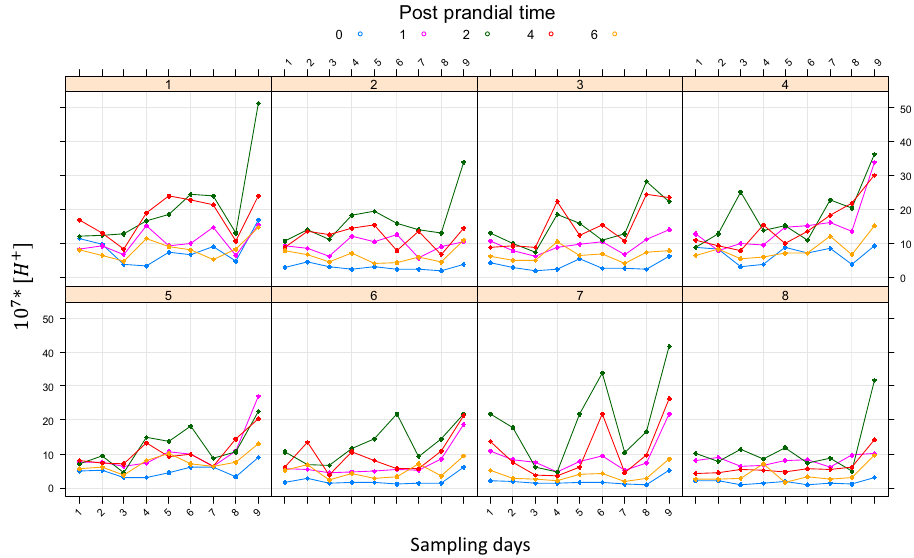
Figure 5. Individuals’ daily variations of [ H + ] . Each panel represents the post-prandial kinetics of individual goats along the 9 days of sampling. Different colours are associated with different time points of post-prandial kinetics of [ H + ] . For clarity, values of [ H + ] are rescaled by 10 7 .